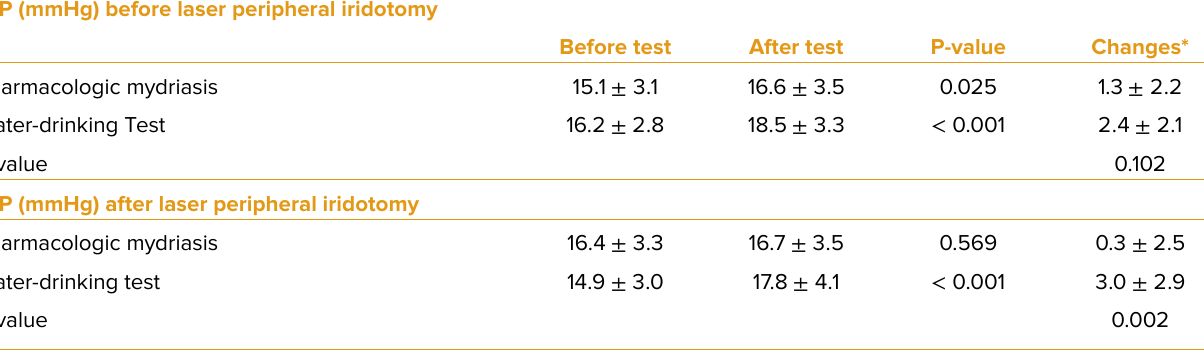
Table 2. Comparison of pharmacologic mydriasis and water-drinking tests as provocative tests in patients suspected of primary angle closure before and after laser peripheral iridotomy IOP (mmHg) before laser peripheral iridotomy Before test After test P-value